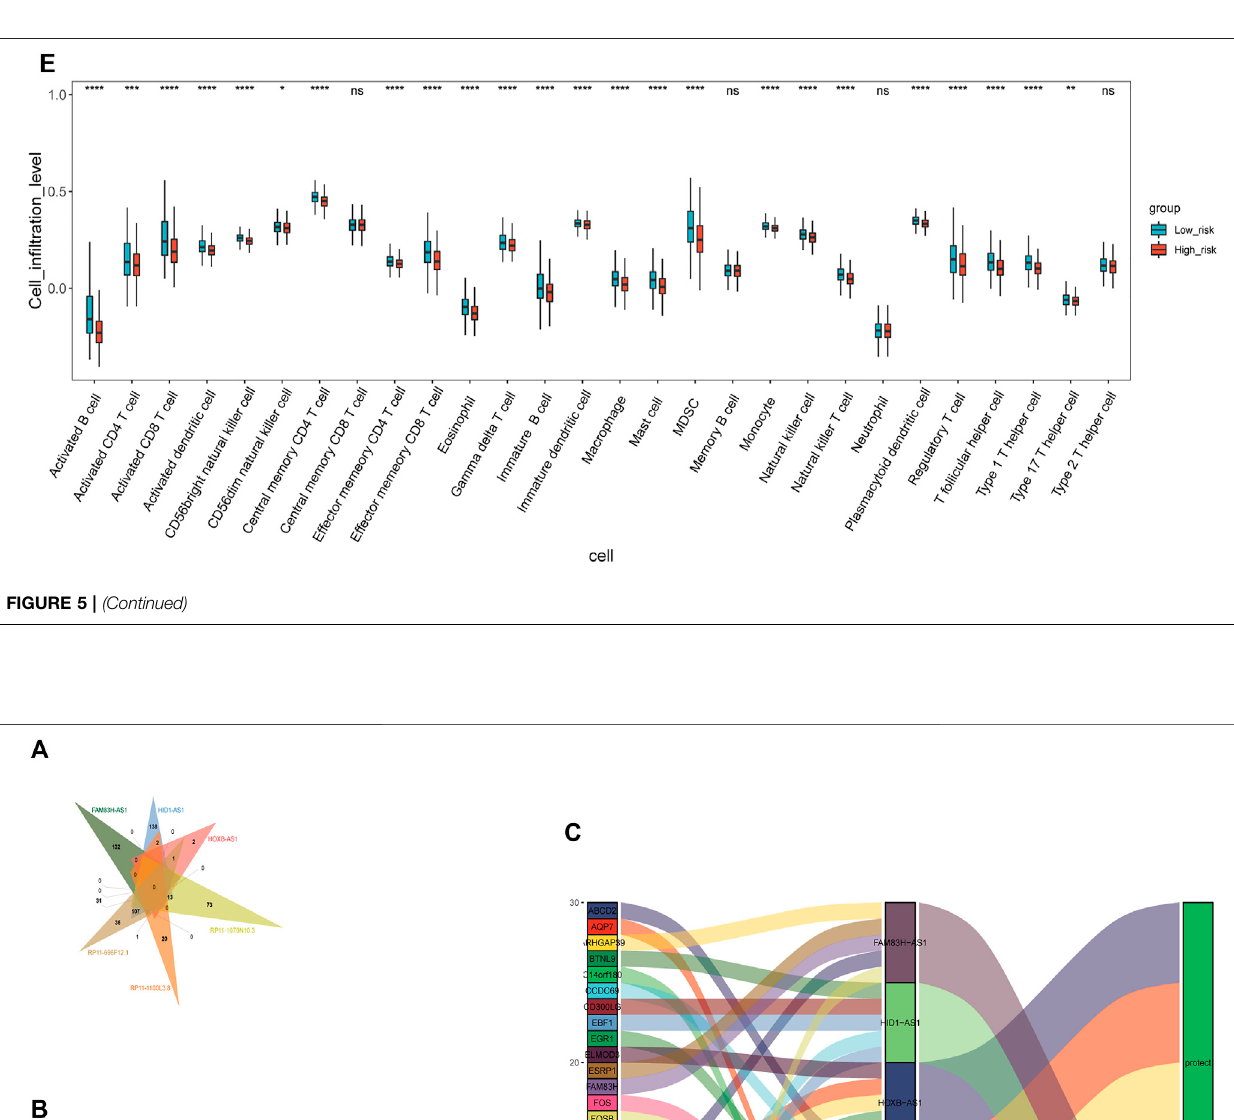
Frontiers in Genetics |